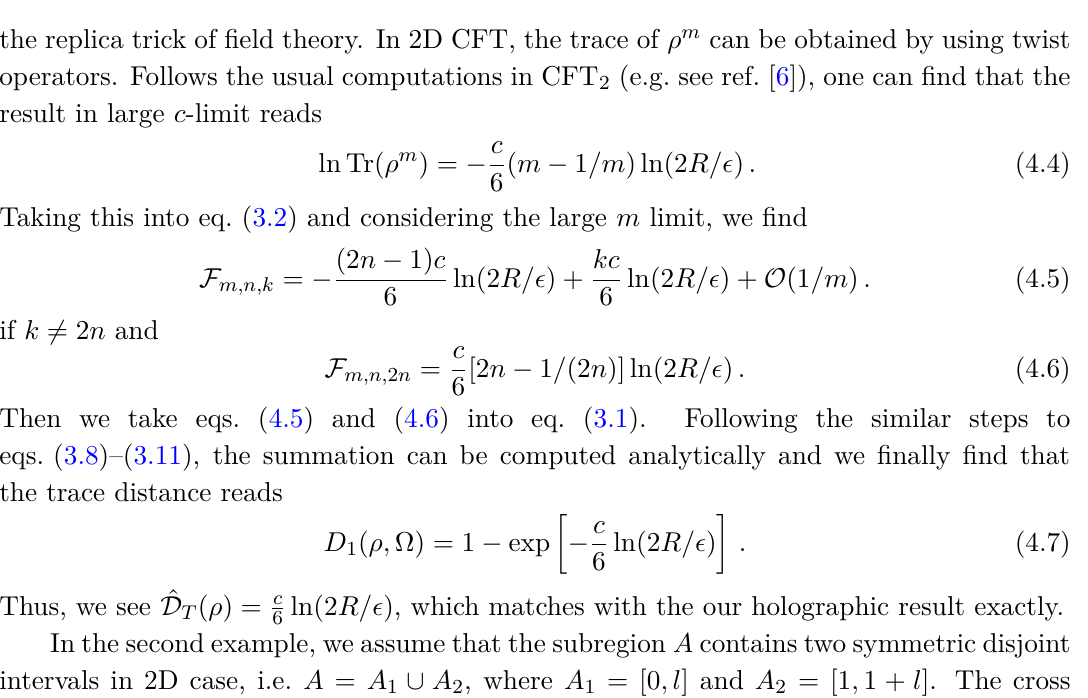
Figure 1 . The cosmic branes of two intervals in the limit x (cid:28) 1 (subfigure (a)) and x → 1 (subfigure